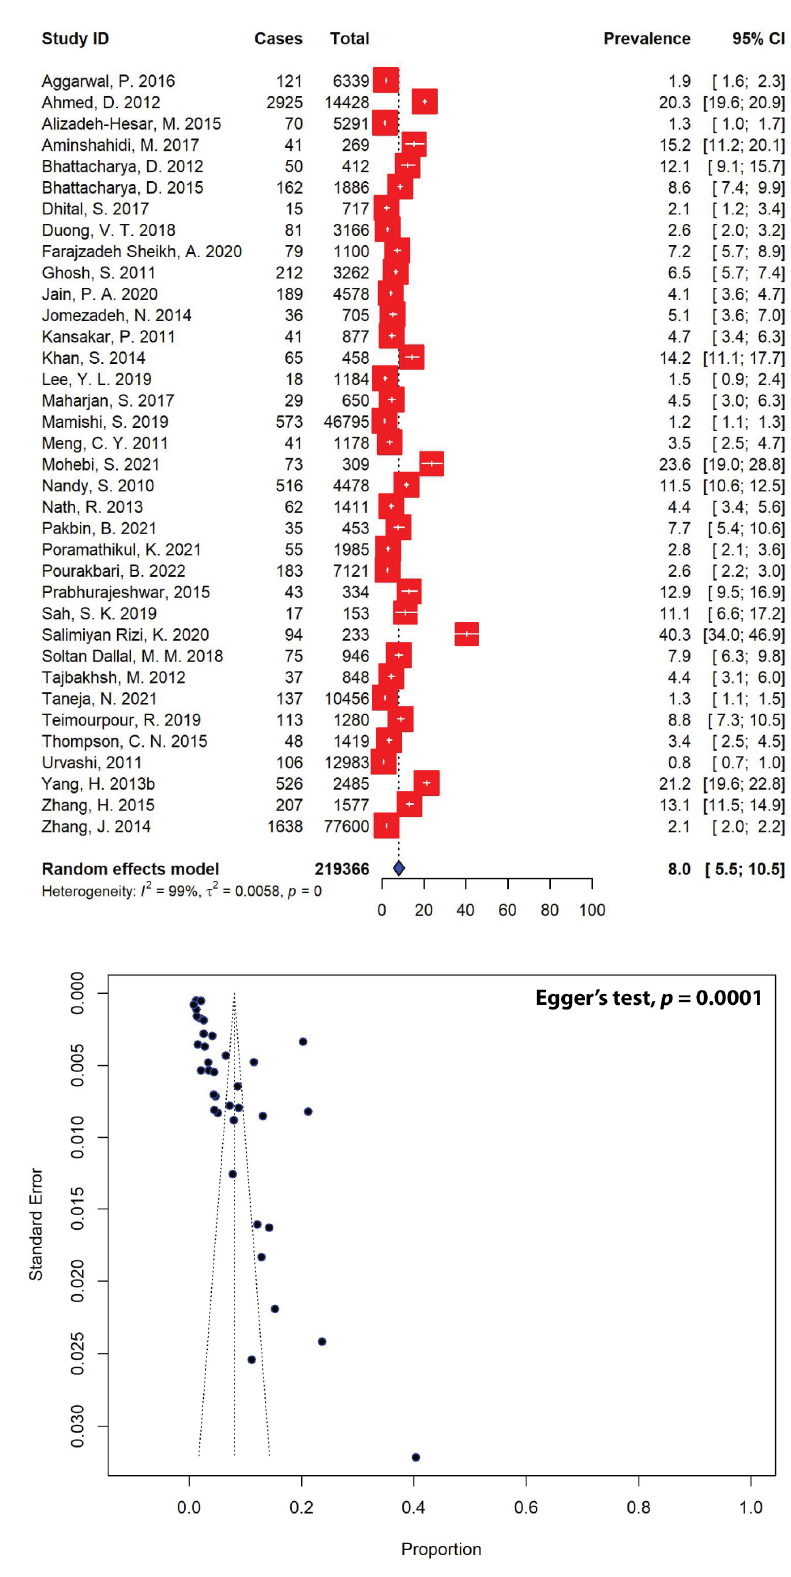
Figure 3. Forest and funnel plots representing the pooled Asian prevalence of Shigella spp. from 36 studies. The estimates of pooled prevalence were calculated using the random-effects model ( top panel ). The distribution of effect estimates is represented by a funnel plot ( bottom panel ). Figures were generated using RStudio software.